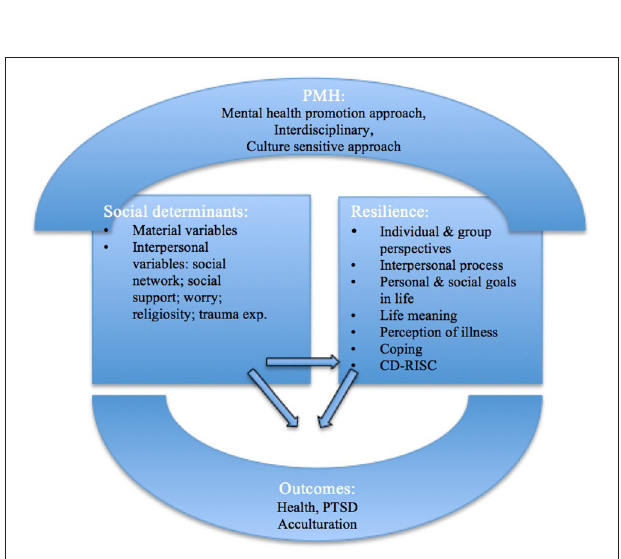
FIGURE 2 | Theoretical overview with a public mental health approach to social determinants, resilience and outcomes. Original figure developed by authors. PMH, Public Mental Health; CD-RISC, Connor-Davidson Resilience Scale; PTSD, Post-traumatic stress